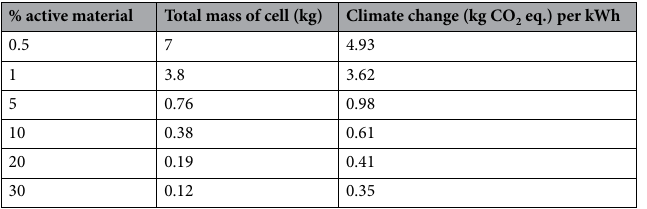
Table 3. Resulting climate change per functional kWh impacts for different % active material for the aq. Al-ion battery from OpenLCA results.